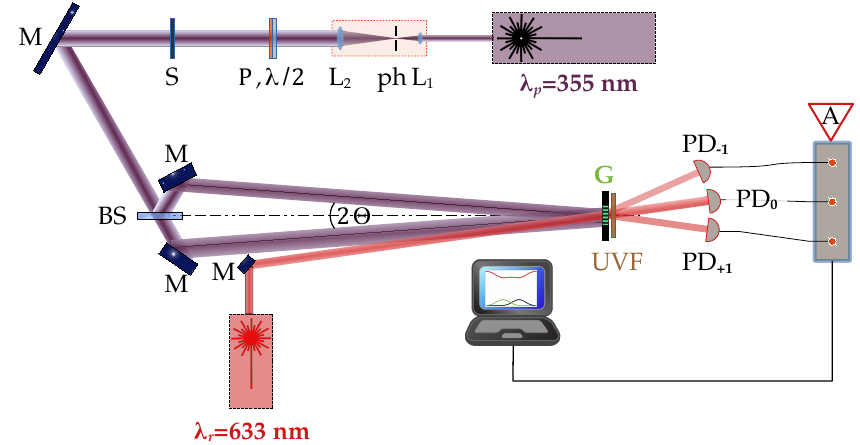
Figure 1. Schematic of the experimental setup. Continuous-wave solid-state laser ( λ p = 355 nm); L i : lenses; ph: pinhole; P: polarizer; λ /2-plate; S: shutter; M: mirror; BS: beam splitter; G: grating (sample); UVF: UV-filter; PD s : Si-photodiodes for the s -th diffraction order; He-Ne laser ( λ r = 633 nm); A: